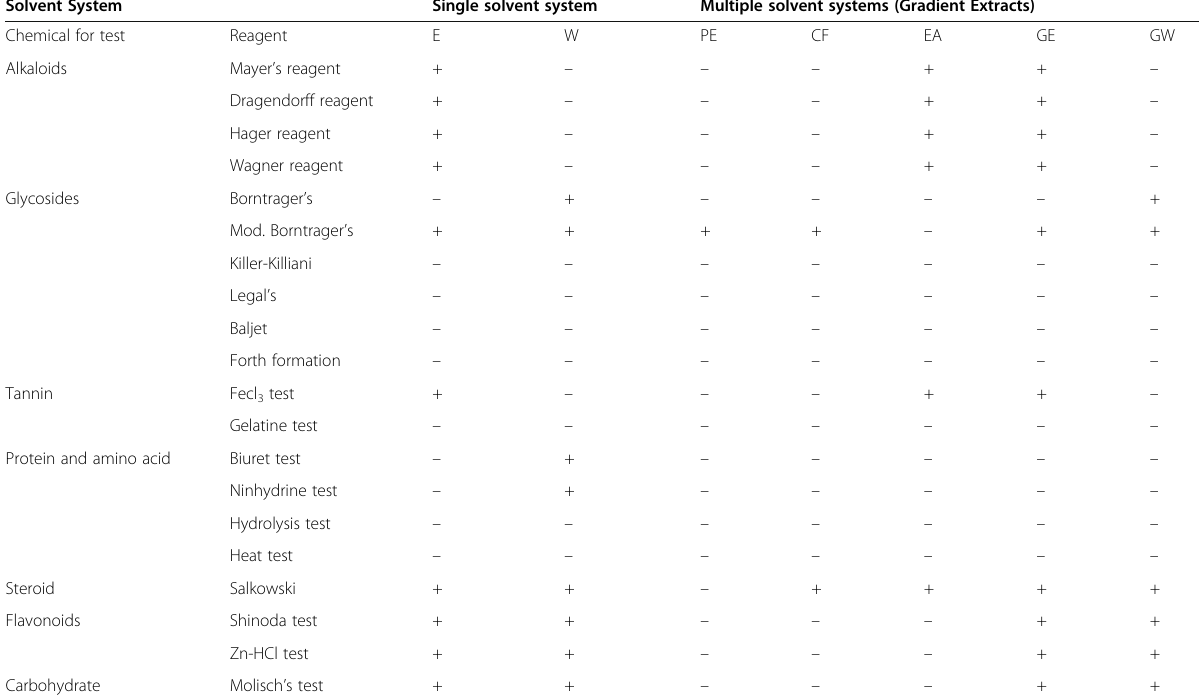
Table 5 Phytochemical examination